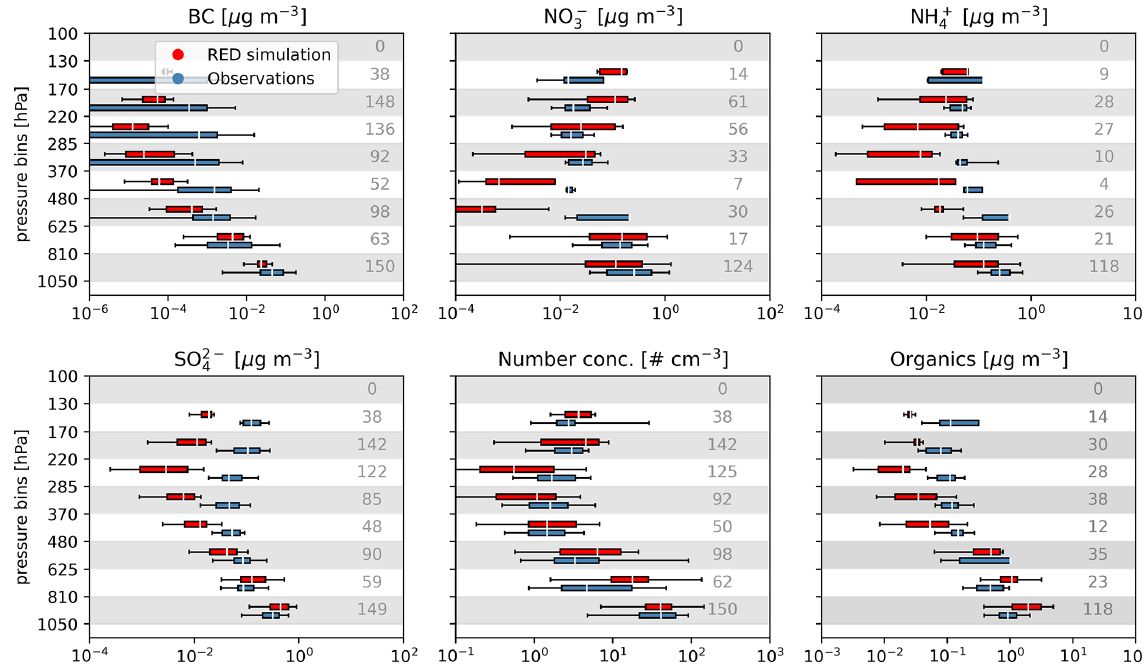
Figure 3. The same as Fig. 2 but for aerosols. Please note the logarithmic scale on the x axis.